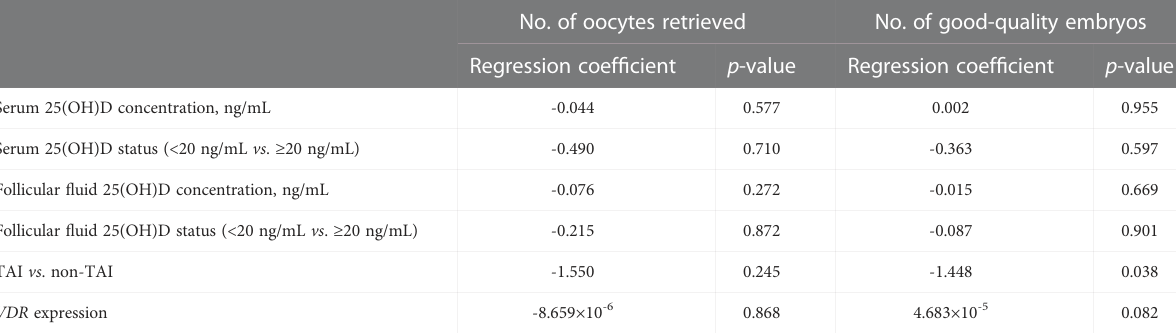
TABLE 4 Linear regression analysis of the number of oocytes retrieved and the number of good-quality